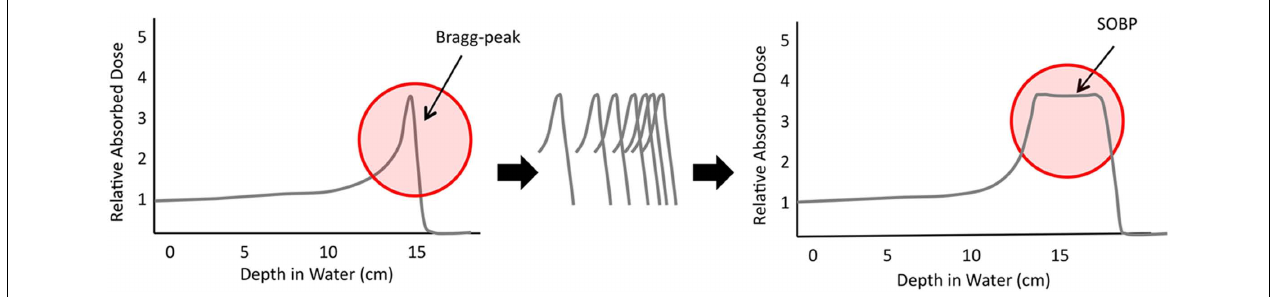
FIGURE 1 | Graphic demonstration of the rapid dosimetric peak and fall-off of the Bragg-peak; the alignment of many Bragg-peaks may allow creation of the spread-out Bragg-peak (SOBP) that allows deposition of radiation in a specific location with essentially no dose deposited beyond